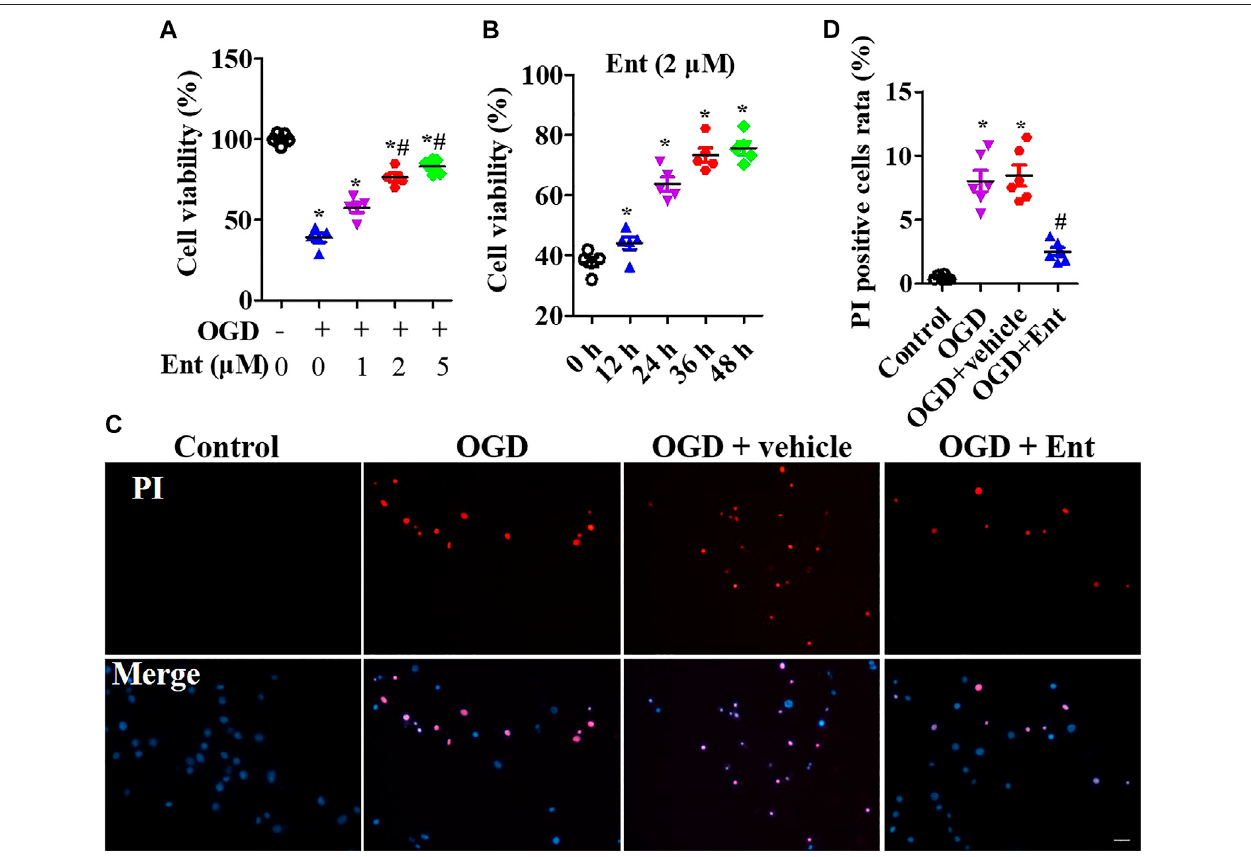
FIGURE5| EntinostatsuppressesOGD-inducedneuronalinjury.IntheOGD-induced neuronaldamagemodel,cellviabilitywasmeasuredafter beingtreatedwith 0, 1, 2, or 5 μ M entinostat for 24 h (A) or treated with 2 μ M entinostat for 12, 24, 36, or 48 h (B) . (C) PI staining of primal neurons at 24 h after being treated with 2 μ M entinostat,andDAPIstainedallcellnuclei. (D) HistogramanalysisofPI-positivecells.Scalebars:50 μ m.Dataareexpressedasthemean ± SEM, n (cid:1) 4.* p < 0.05, vs. the control group; # p < 0.05, vs. the OGD group.